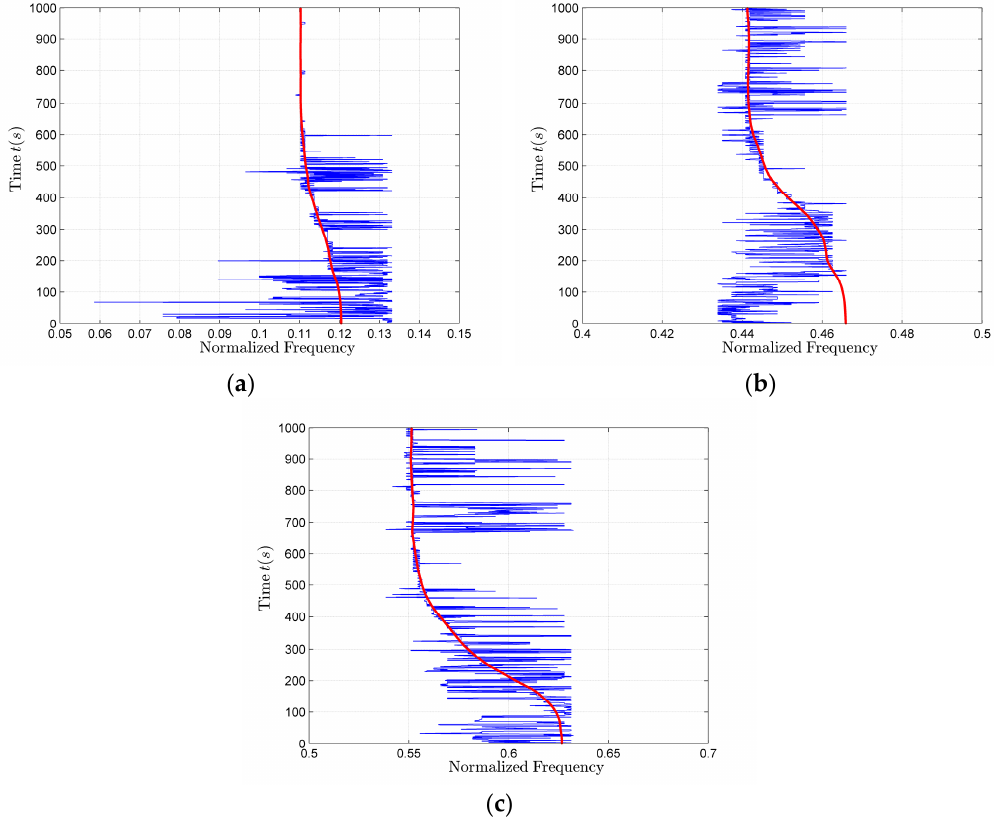
Figure 16. The spectra and frequency sequences extraction results. ( a ) In the band from 0.05 to 0.15; ( b ) In the band from 0.4 to 0.5; ( c ) In the band from 0.5 to 0.7. Signals in the 0.05–0.15, 0.4–0.5, 0.5–0.7 bands are used for parameter estimation. Through the